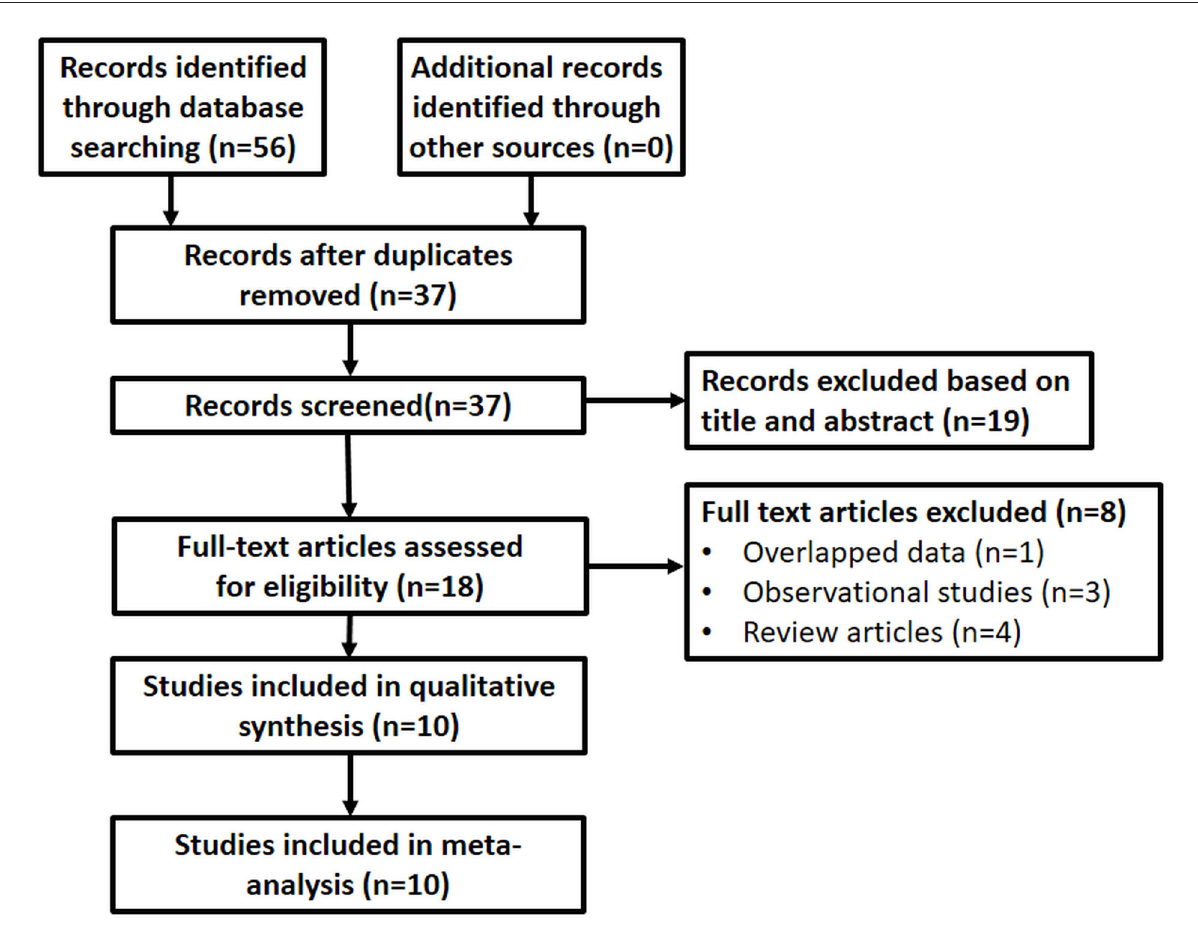
FIGURE1 Flowchart of article selection. The literature search strategy identified 53 records initially. After the detailed screening, ten trials, enrolling 5,004 individuals, fulfilled all selection criteria and were included in the